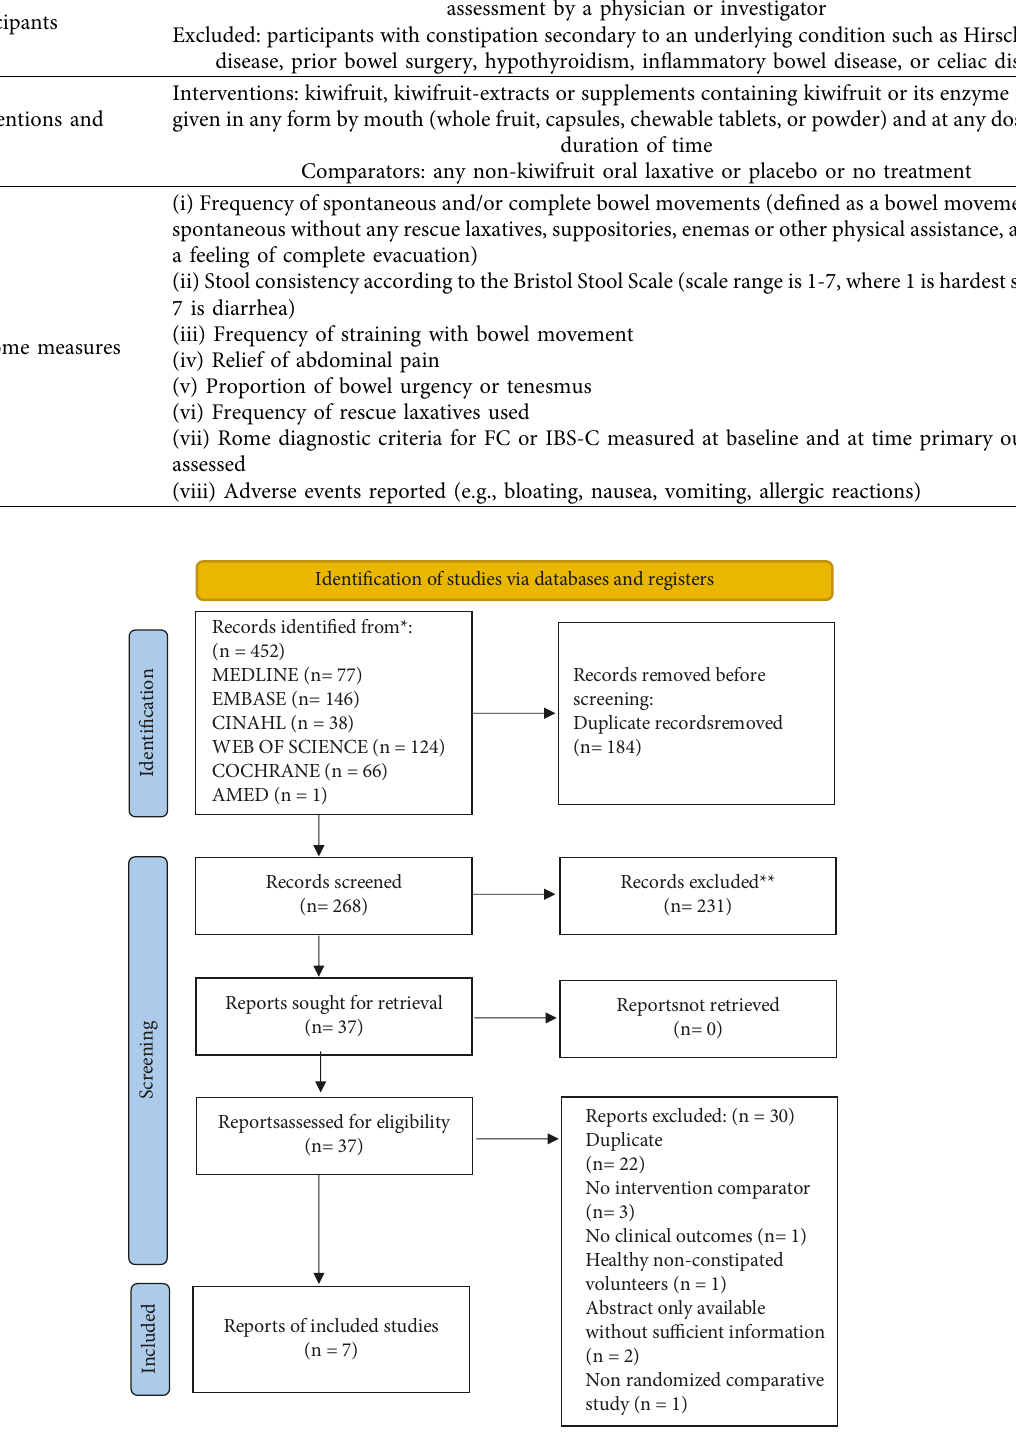
Figure 1: Preferred Reporting Items for Systematic Reviews and Meta-Analyses flow diagram.